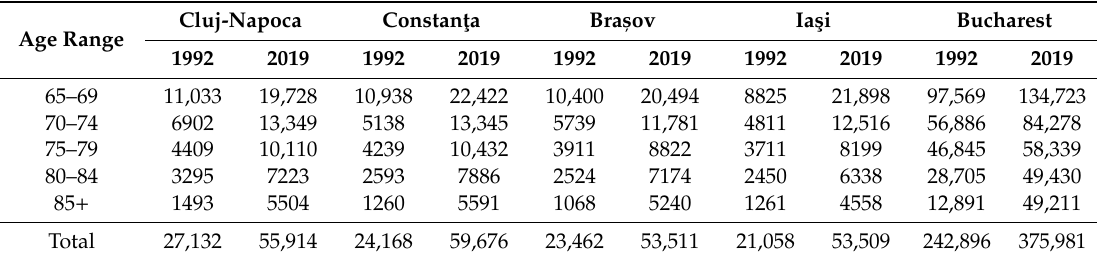
Table 4. The older population of main Romanian cities per age cohort